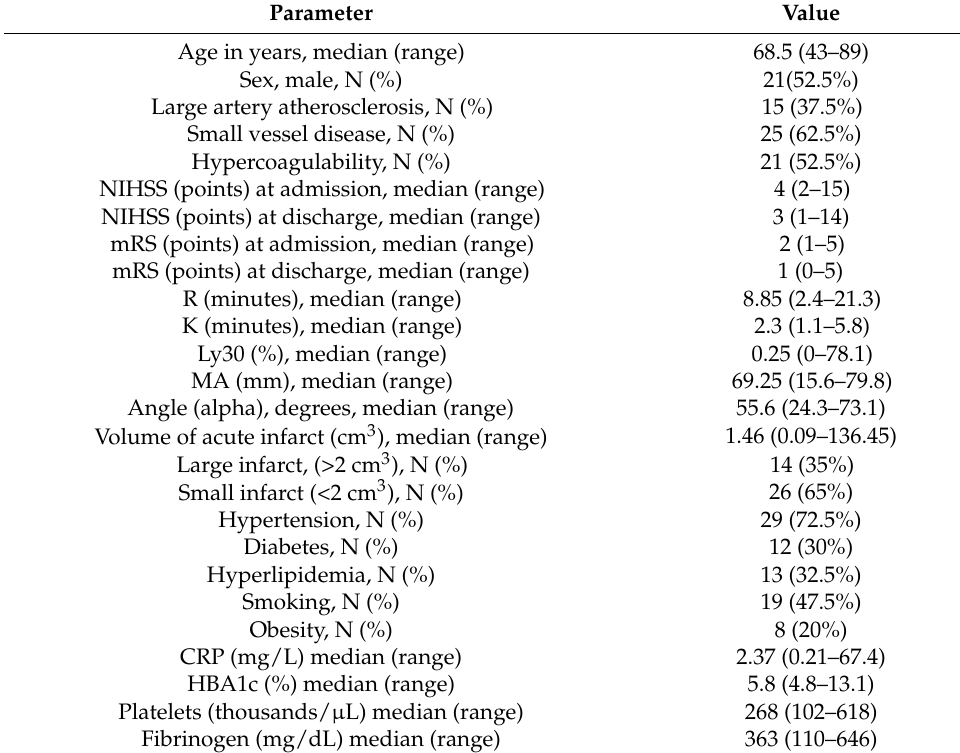
Figure 1. Differences in diameter of clot (measured as MA-maximum amplitude in mm) between stroke subjects with large (>2 cm 3 ) and small (<2 cm 3 ) ischemic infarcts. Table 1. The baseline characteristics of ischemic stroke subjects (n =